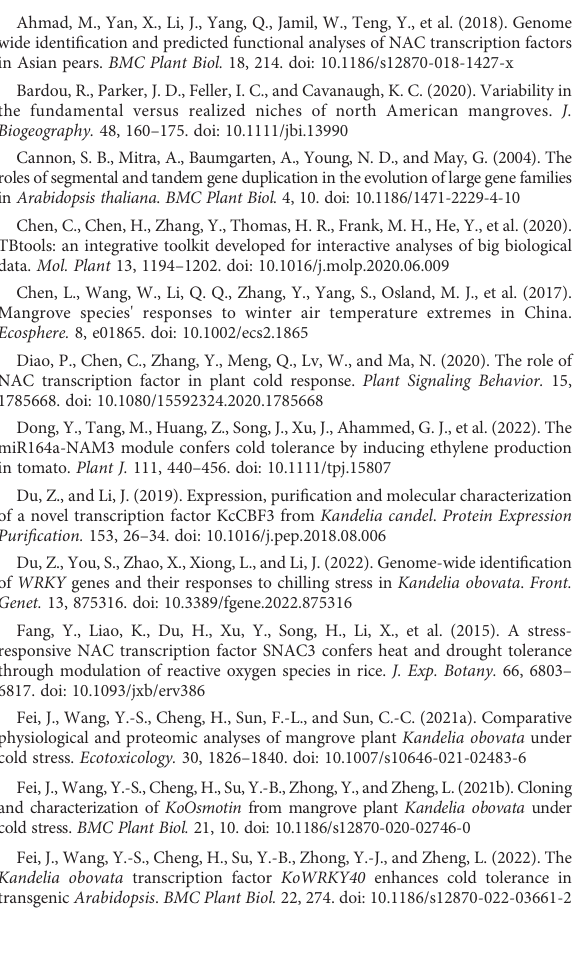
SUPPLEMENTARY FIGURE 1 cis -acting elements in each KoNAC . The distribution of 20 cis -acting elements in the 2000 bp upstream promoter region is shown. The different types of cis -acting elements are represented by different colors, as shown on the right. SUPPLEMENTARY FIGURE 2 Coexpression network of KoNACs with other genes in Kandelia obovata under chilling stress. The coexpression network was established between 13 KoNACs and 284 signi fi cantly expressed mRNAs whose absolute Pearson correlation coef fi cient values were equal to or greater than 0.95. Within this coexpression network, 379 and 2 pairs were positively and negatively correlated, respectively. The yellow circles represent KoNAC genes, while the blue rectangles represent the coexpressed genes. The solid gray lines represent positive correlations, while the dashed green lines represent negative correlations. SUPPLEMENTARY FIGURE 3 The percent change in the expression levels of KoNACs under the fi rst cold treatment is negatively correlated with the number of introns. The percent change in the expression levels of KoNACs under the fi rst cold treatment was calculated with the formula (E 1 -E 0 )*100%/E 0 . E 1 and E 0 indicate the expression levels of KoNACs under the fi rst cold treatment and in the control,